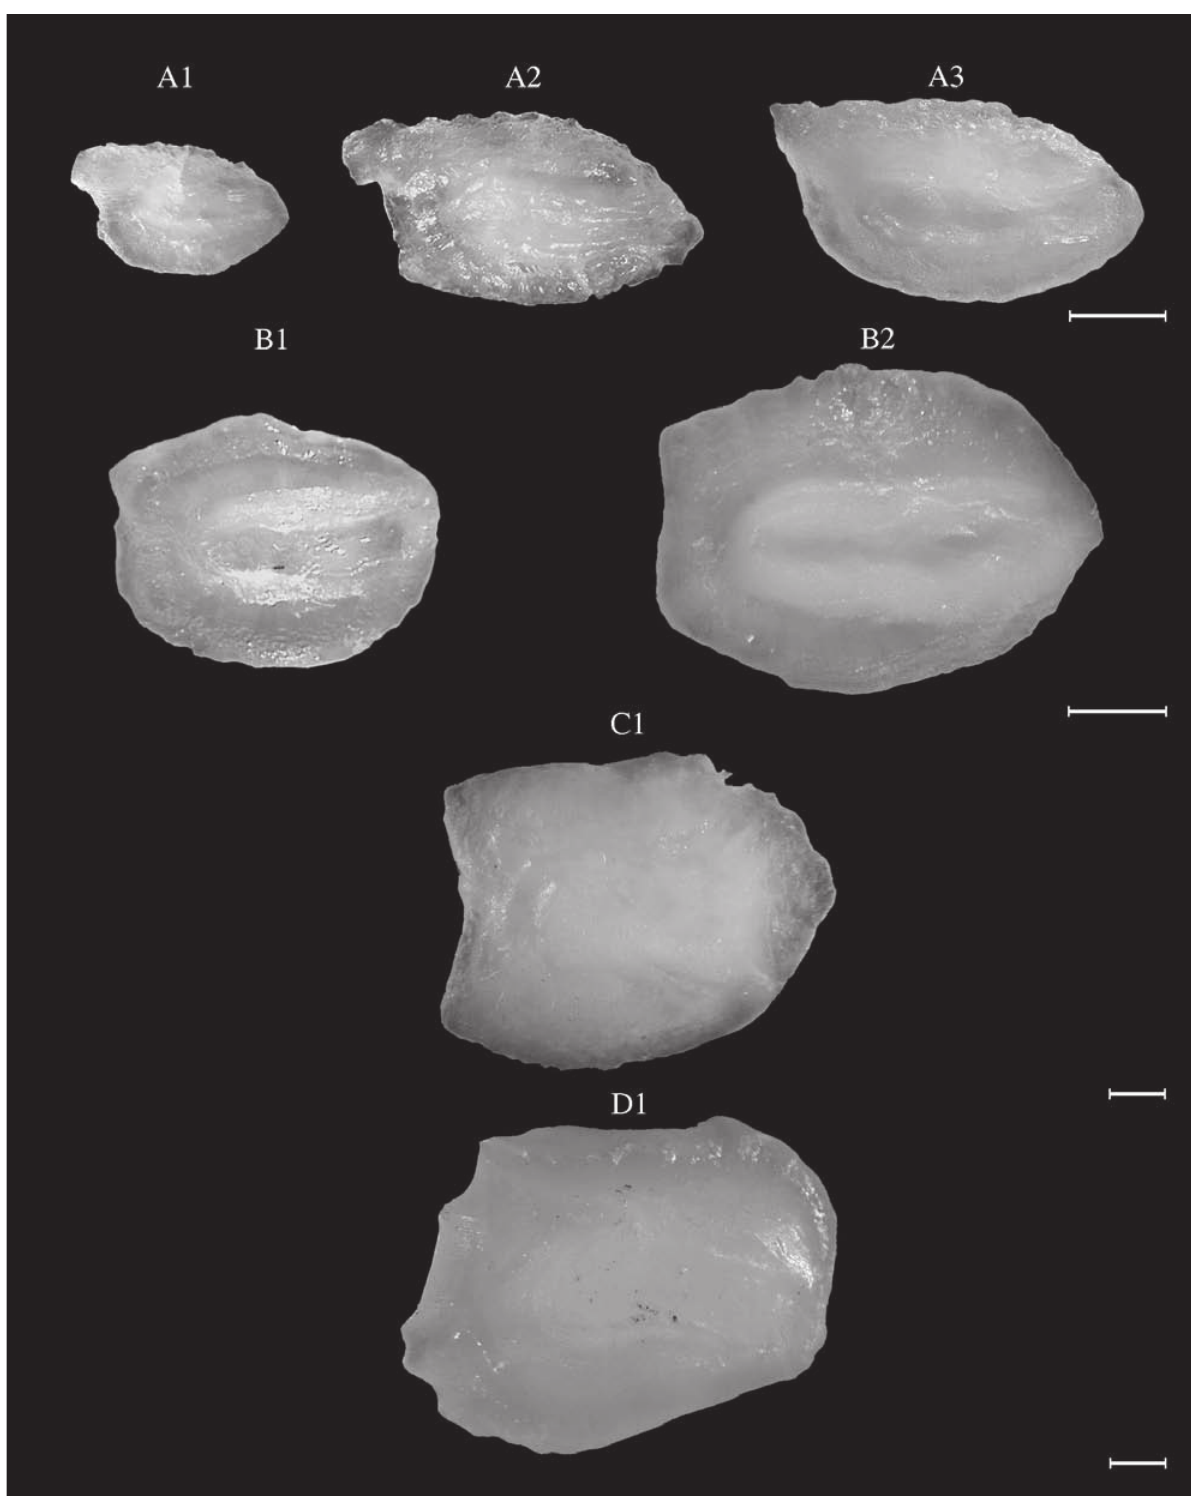
Fig. 94. – Synaptura lusitanica. TL: A1, 16.2 cm (NEA); A2, 31.0 cm (WM); A3, 35.0 cm (NEA). Synapturichthys kleinii. TL: B1, 23.0 cm (WM); B2, 38.0 cm (CEA). Cynoglossus browni (CEA). TL: C1, 43.5 cm. Cynoglossus canariensis (CEA). TL: D1, 48.5 cm. Scale bar = 1